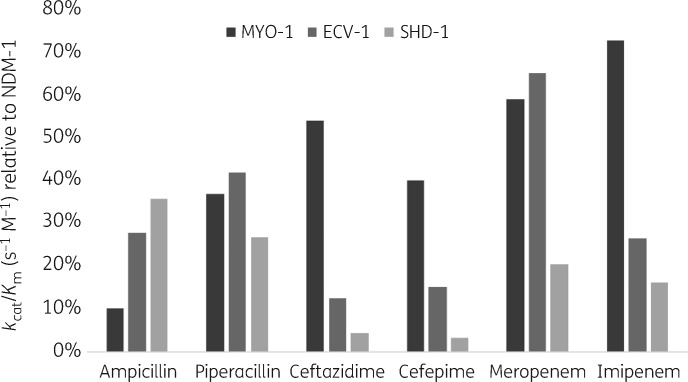
Relative catalytic efficiencies [kcat/Km (s−1 M−1)] of MYO-1, ECV-1 and SHD-1 compared with NDM-1.